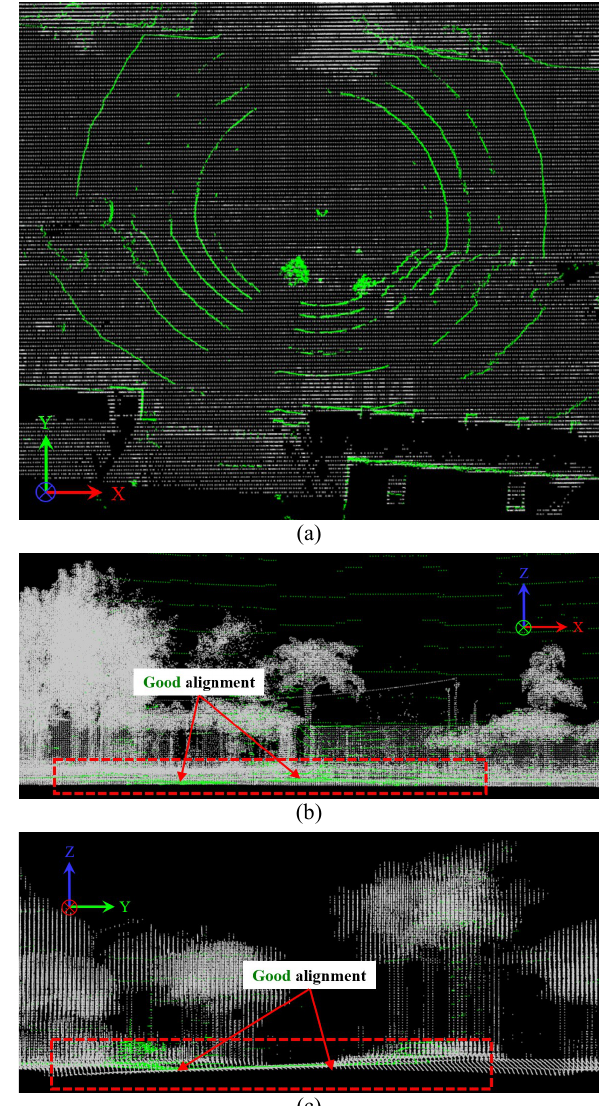
Figure 5 . Georeferenced points before calibration (red points): (a) xy-plane (top-view), (b) xz-plane (side-view), and (c) yz- plane (front-view).